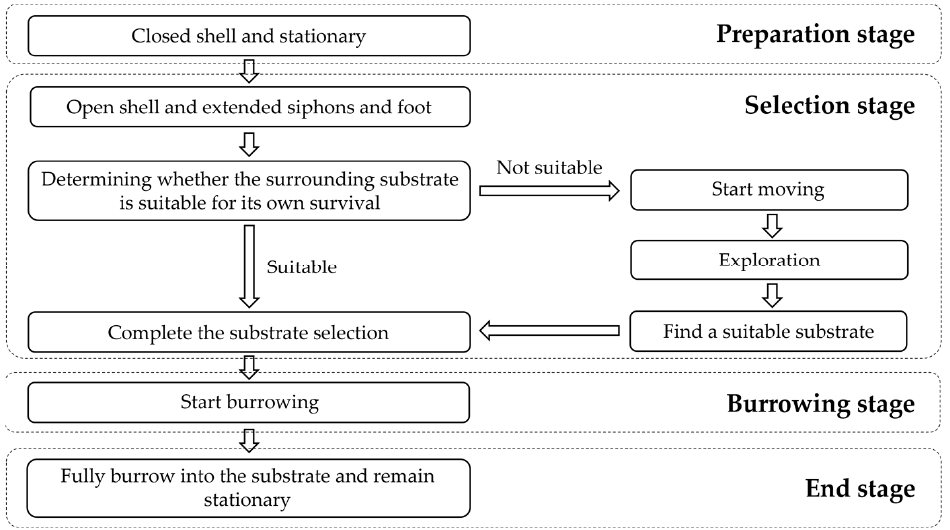
Figure 9. The different stages in the substrate selection process of Meretrix meretrix .